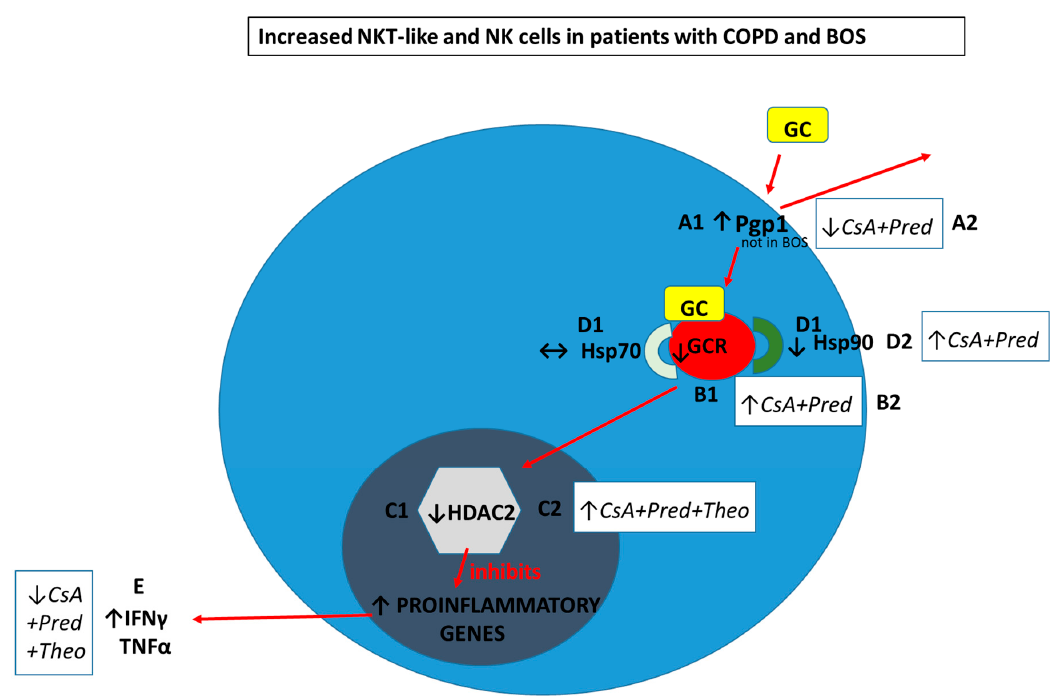
Figure 3. Schematic diagram summarizing reported findings in peripheral blood CD28nullCD8+NKT-like cells and NK cells in COPD and BOS patients compared with aged-matched control subjects. The percentage of CD28nullCD8+NKT-like cells and NK cells are increased in COPD and BOS patients compared with aged-matched control subjects. This figure was adapted from [10].